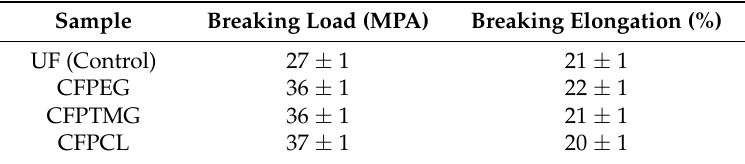
Table 4. Tensile strength and elongation of uncoated and coated fabric.